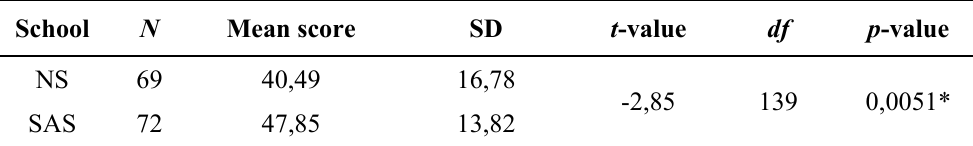
Table 2 : School percentage means for learners in the